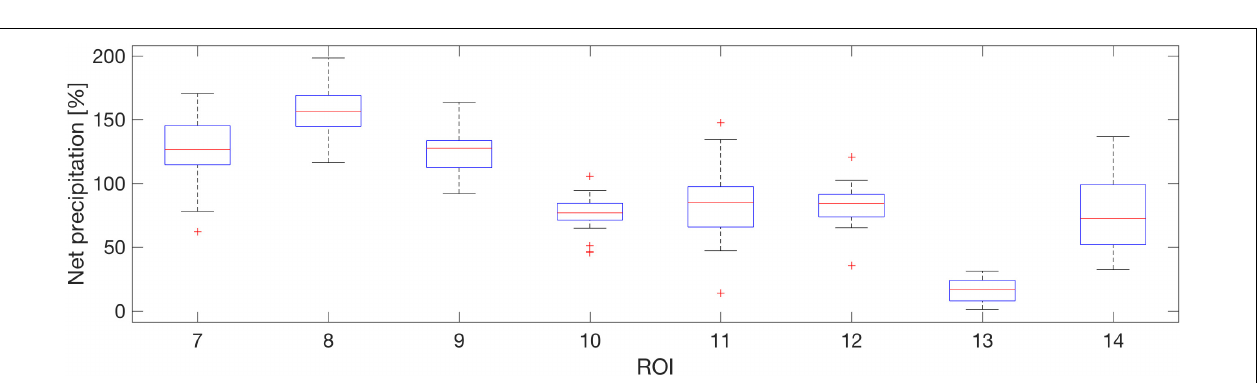
FIGURE 7 | Trends of forest cover dynamics per ROI based on 30 years of Landsat NDVI data. The numbers depict the ROI ID; IDs marked with a plus show ROIs with a significant forest cover trend.